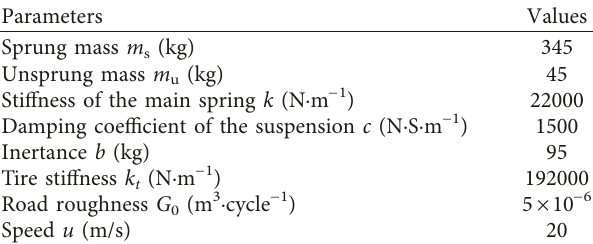
Table 6: Summary of the simulation